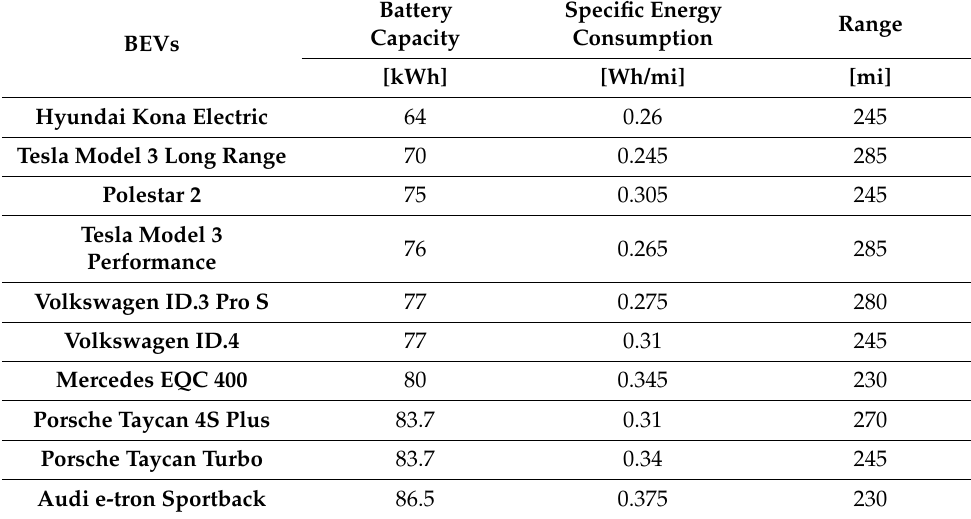
Table 6. Some BEVs having a range of 200+